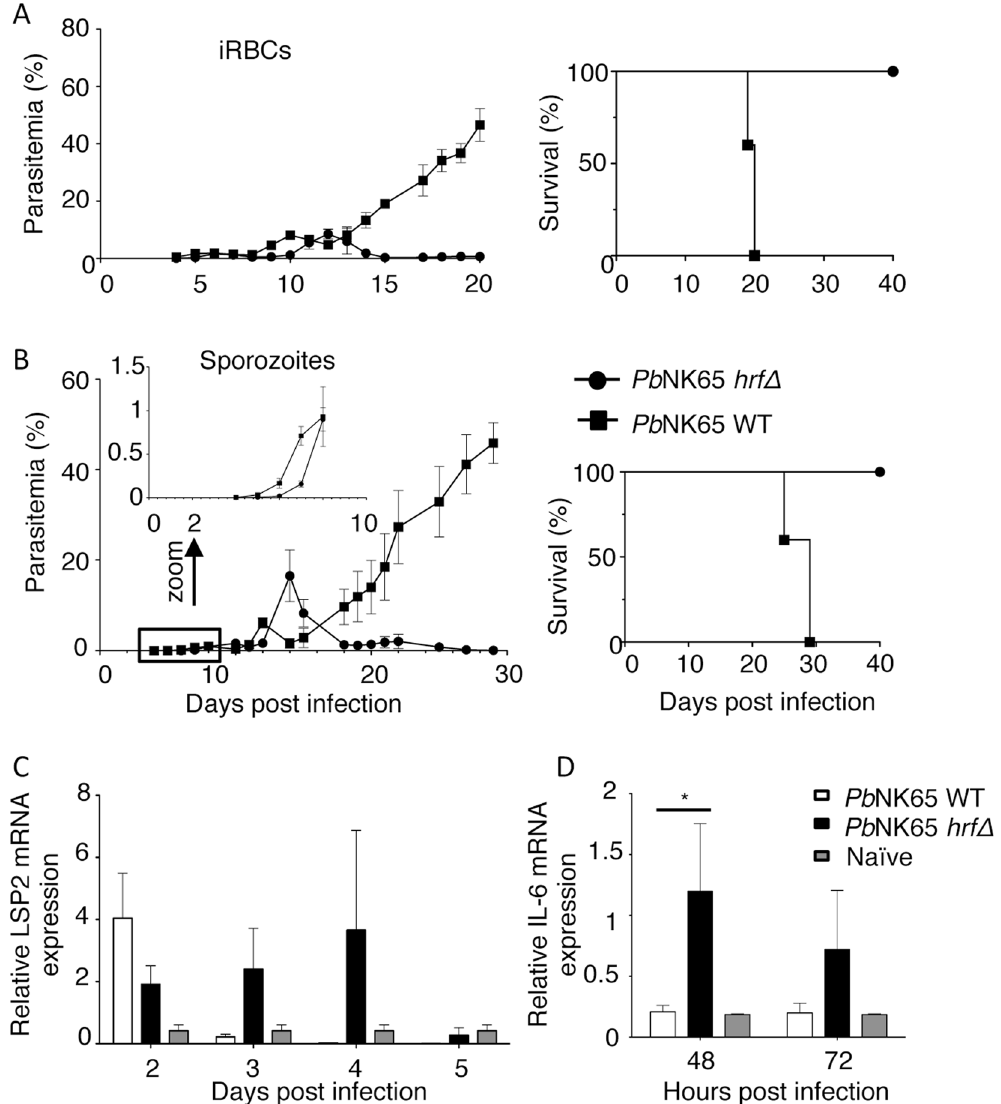
Figure 1. Marked differences in parasitaemia between WT and Pb NK65 hrf Δ -infected mice during blood stage development. Blood-stage parasitemia and survival (Kaplan-Meier survival plots) of C57BL/6 mice after ( A ) i.p. injection of 10 5 iRBCs or ( B ) i.v. injection of 10 3 isolated sporozoites of WT or Pb NK65 hrf Δ parasites were measured at indicated time points. After infection with WT or Pb NK65 hrf Δ sporozoites, livers were collected at indicated time points and RT-qPCR analysis were used to measure ( C ) the kinetics of parasite load using the liver stage specific LSP-2 marker expression relative to the parasite control gene HSP70 and ( D ) IL-6 expression using IL-6 mRNA expression relative to mouse HPRT mRNA levels. Error bars, SEM. Data are representative of two independent experiments with 5 mice per group. ( * p < 0.05; Mann Whitney